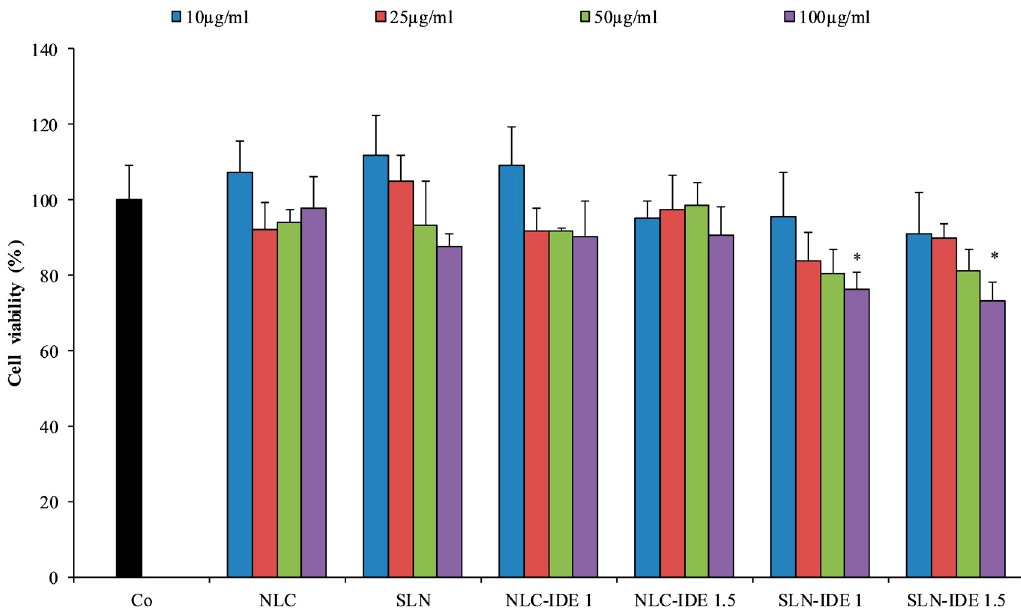
Figure 5. Effect of increased doses of idebenone (IDE)-loaded solid lipid nanoparticles (SLN) and nanostructured lipid carriers (NLC) on the percentage of vitality of HS68 fibroblast cells, determined by MTT (each data is presented as mean ± SD; n=12). Statistical analysis for the comparison: * p < 0.05 vs. Co. Co = control (no treatment), NLC = unloaded nanostructured lipid carrier, SLN = unloaded solid lipid nanoparticles, NLC-IDE 1 = NLC loaded with IDE 1% w/w; SLN-IDE 1 = SLN loaded with IDE 1% w/w; NLC-IDE 1.5 = NLC loaded with IDE 1.5% w/w, SLN-IDE 1.5 = SLN loaded with IDE 1.5% w/w.